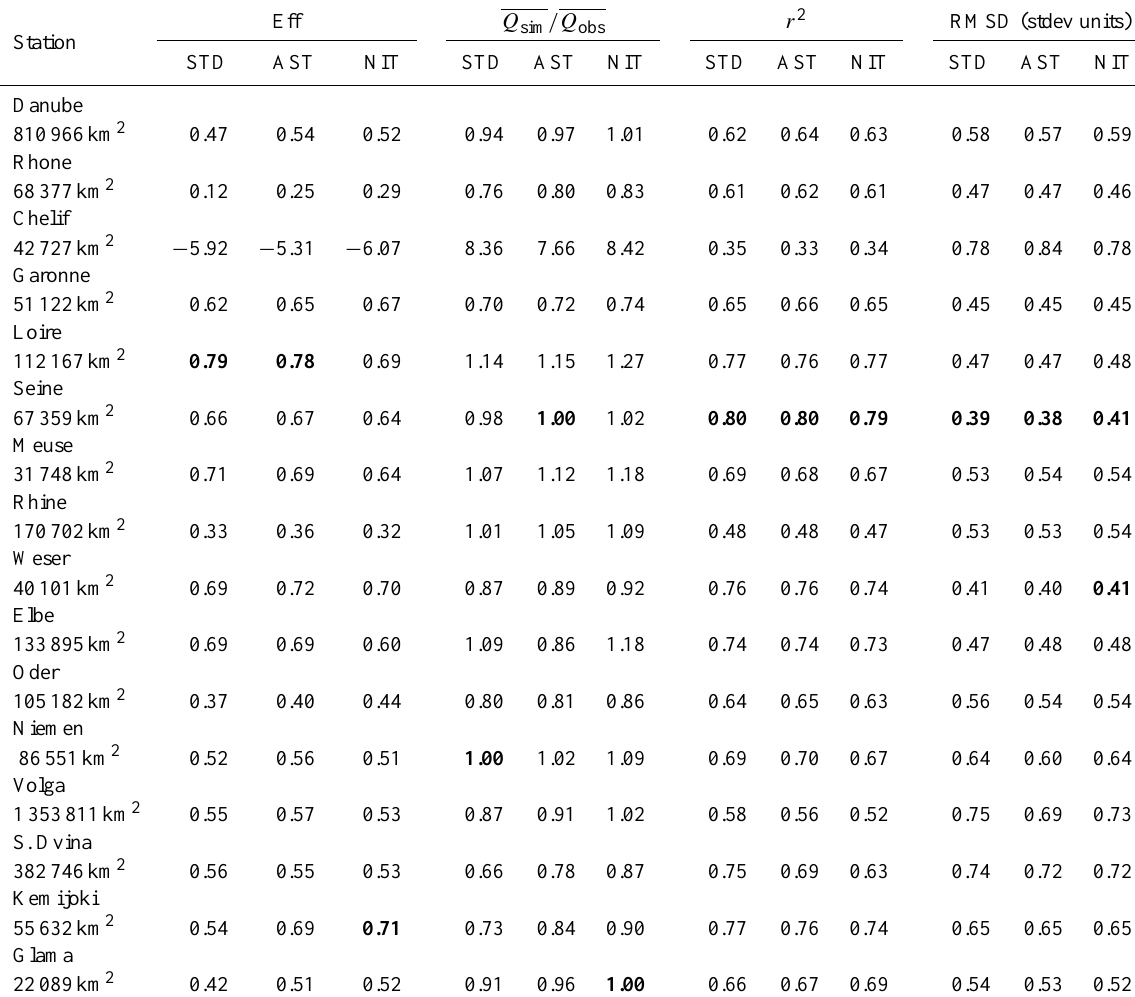
Table 2. Scores obtained for 16 stations corresponding to the outlet of the largest CNF basins ( > 20 000km 2 ) . The Eff, Q sim /Q obs , and r 2 scores are based on daily values. The RMSD score is based on scaled monthly anomalies. Mean annual cycles of each stations are given in Fig. 7. The drainage area considered in the TRIP hydrological model is given together with the name of the river. For each score and each simulation, the best score value is presented in